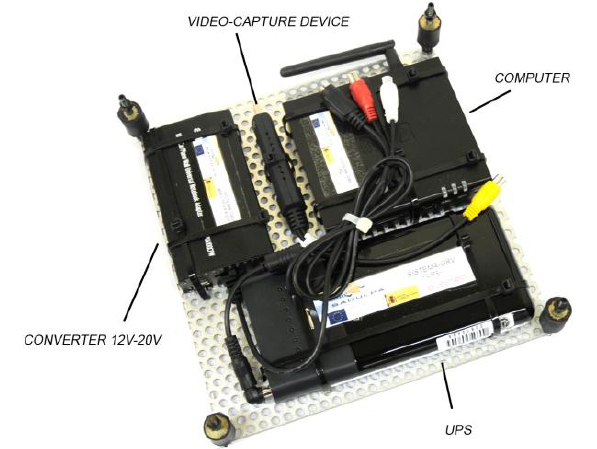
Figure 2. On-board computer and external